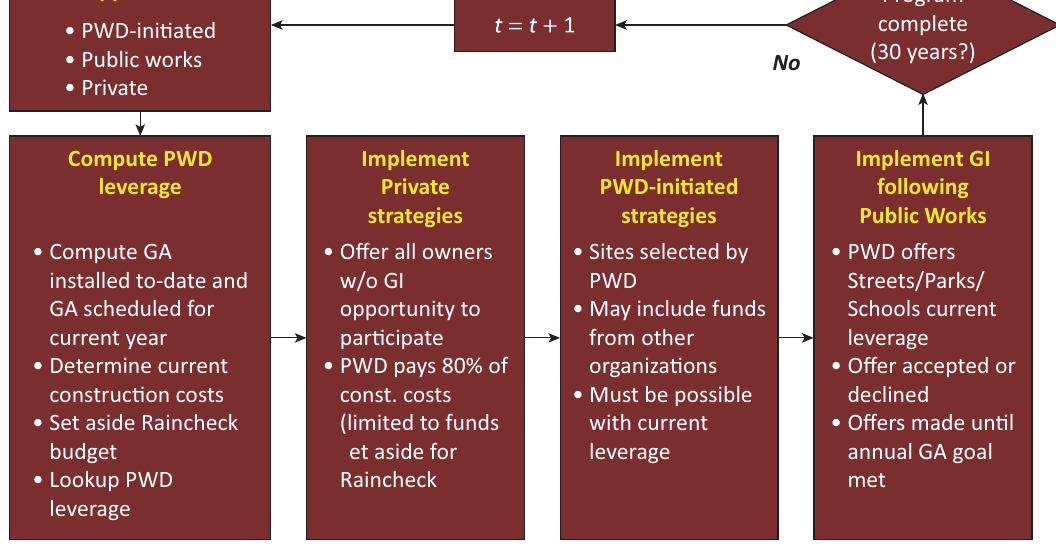
Figure 2. Flowchart depicting PWD’s decision-making model.